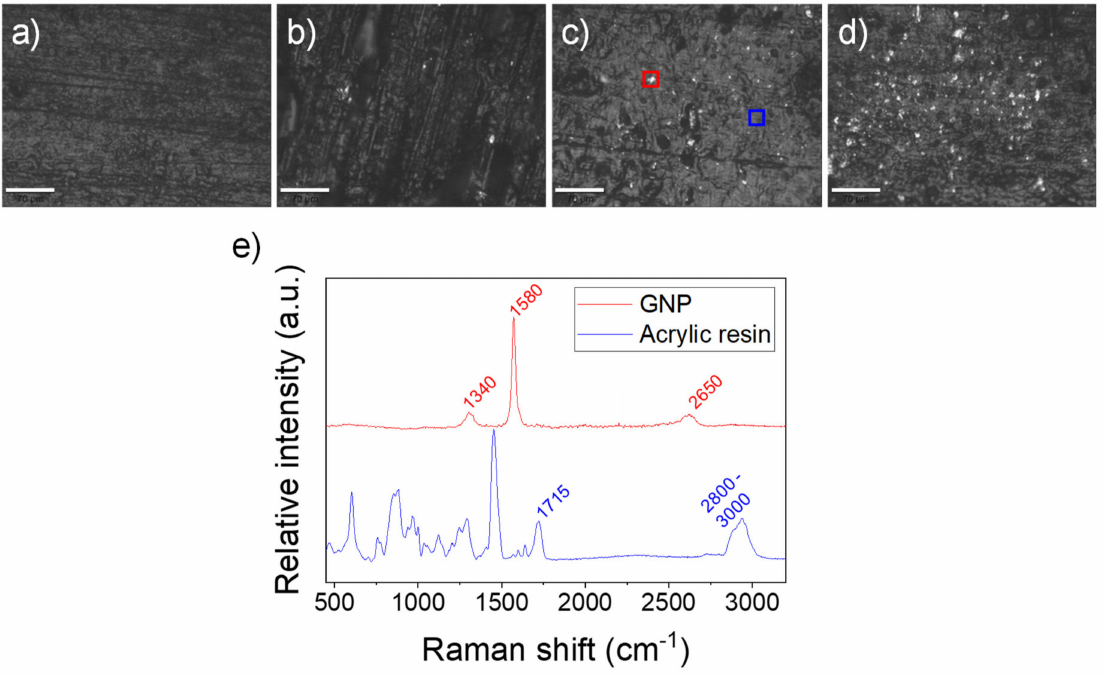
Figure 3. Optical micrographs of printed resins containing ( a ) no GNP; ( b ) 0.5 wt % GNP; ( c ) 1.0 wt % GNP and ( d ) 2.5 wt % GNP; ( e ) characteristic Raman single-spectra taken in two di ff erent spots of a sample containing 1.0 wt % GNP, marked in Figure 3c. Scale bar: 70 µ